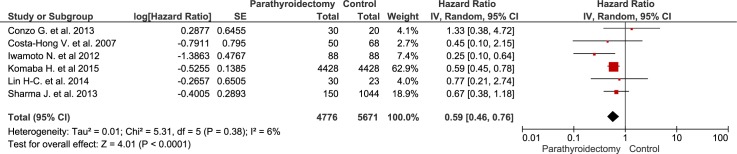
The effect of parathyroidectomy on cardiovascular mortality.